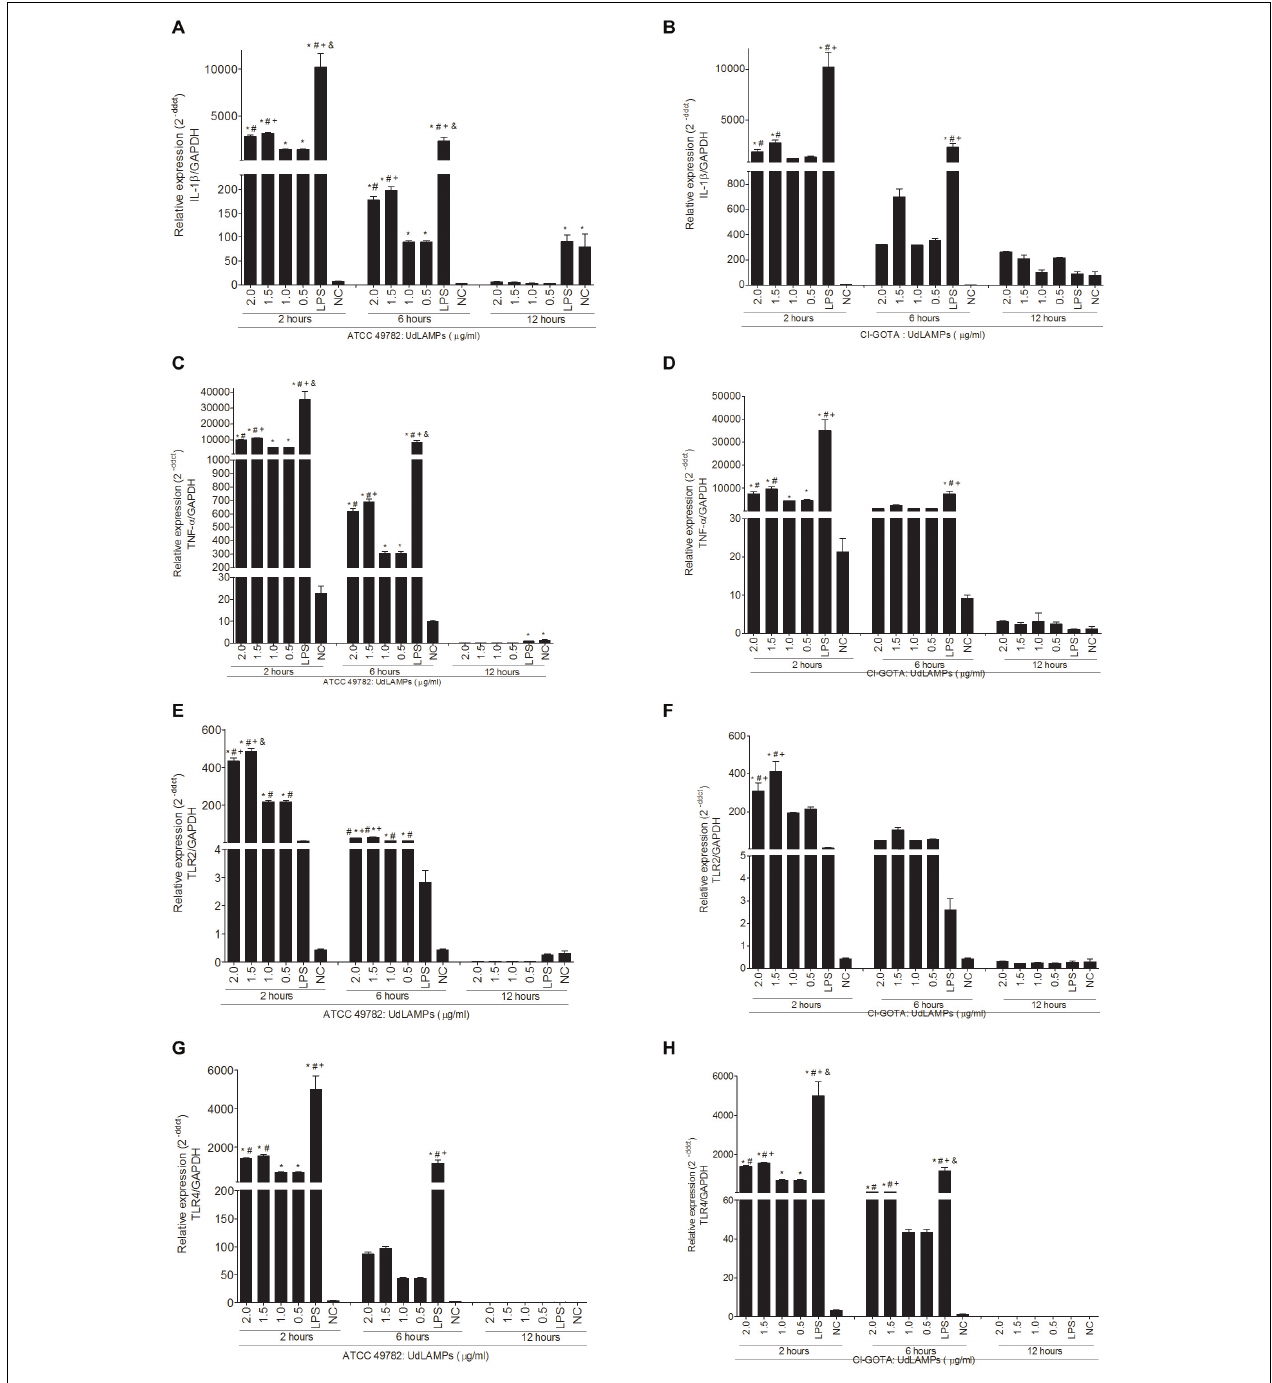
FIGURE 4 | Gene expression in bovine macrophages induced by different concentrations of UdLAMPs after 2, 6, and 12 h of inoculation. (A) IL-1 β gene expression incubation with UdLAMPs of ATCC 49782 strain. (B) IL-1 β gene expression after incubation with UdLAMPs of the CI-GOTA strain. (C) TNF- α gene expression after incubation with UdLAMPs of ATCC 49782 strain. (D) TNF- α gene expression after incubation and others with UdLAMPs of CI-GOTA strain. (E) TLR2 gene expression after incubation with UdLAMPs of ATCC 49782 strain. (F) TLR2 gene expression after incubation with UdLAMPs of CI-GOTA strain. (G) TLR4 gene expression after incubation with UdLAMPs of ATCC 49782 strain. (H) TLR4 gene expression after incubation with UdLAMPs of CI-GOTA strain. Treatments were compared using Kruskal-Wallis non-parametric test followed by the Dunn post-test. PBS was used as negative control (CN) and 100 ng/mL of LPS was used as positive control. Statistically different groups are those presenting different symbols. Statistical significance ( p < 0.05) is represented by the symbols ( ∗ difference with the NC group, # difference with the 1,5 mg/ml group, + difference with the 1,0 mg/ml group, & difference with the 0,5 mg/ml group). Data are expressed as mean ± standard deviation ( n =